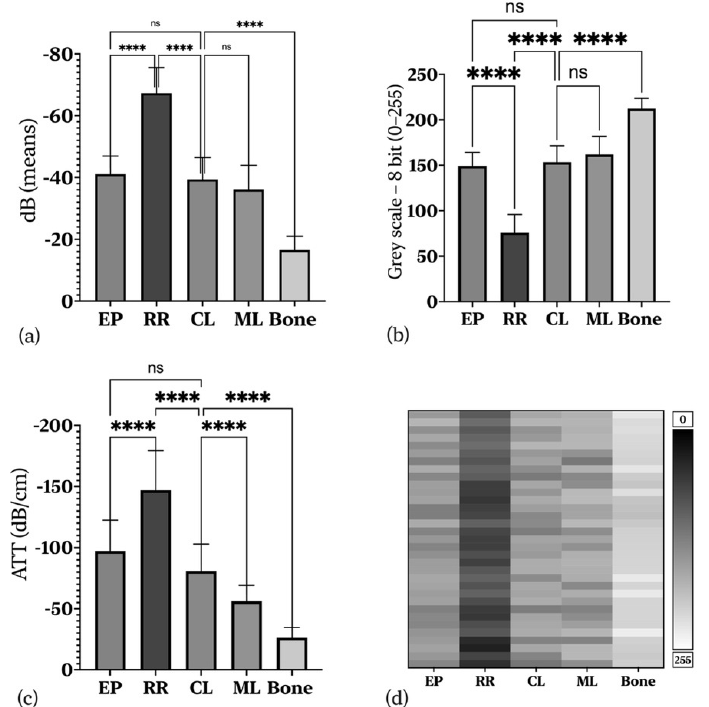
Figure 2. Histograms and heatmap showing the comparisons between groups; 95% C.I. is represented; ns = not significant; asterisk = the mean difference is statistically significant ( p ≤ 0.01). ( a ) Echo intensity comparison between groups. ( b ) Greyscale analysis between groups. ( c ) Relative attenuation (mean difference) between groups. ( d ) The heatmap shows the average of the ultrasound intensity variations, in grayscale, among the tissue layers in each analyzed case.